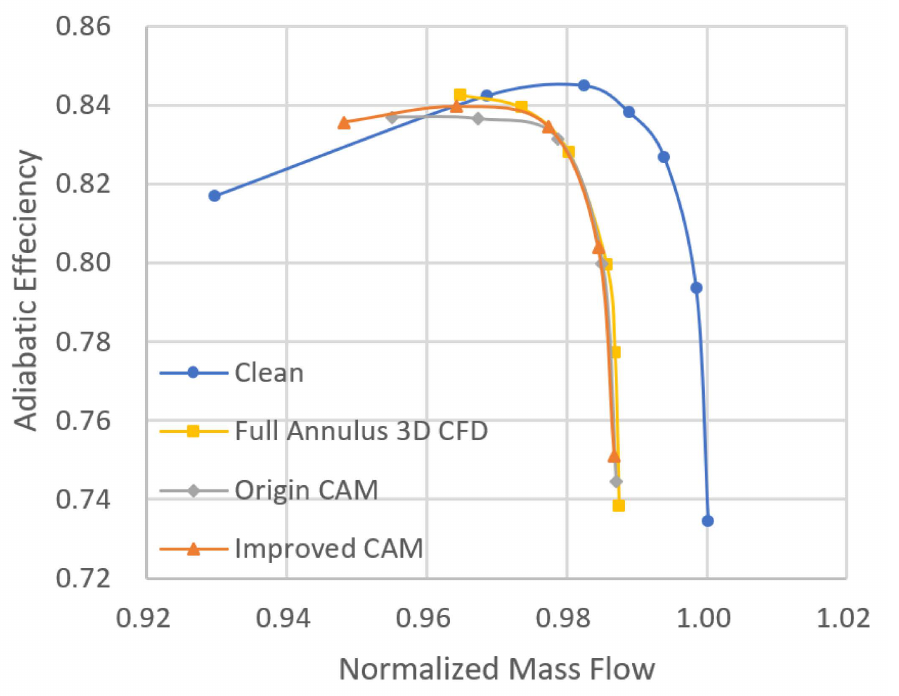
Figure 16. Adiabatic efficiency versus mass flow rate under distortion at 100%